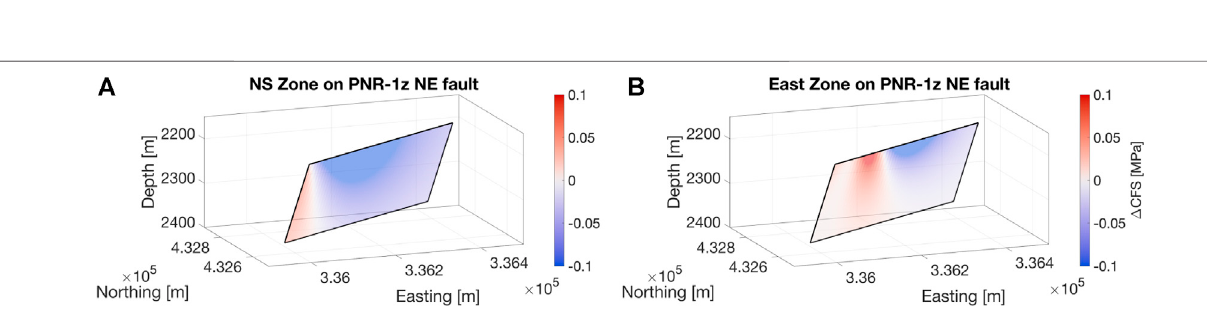
Frontiers in Earth Science |